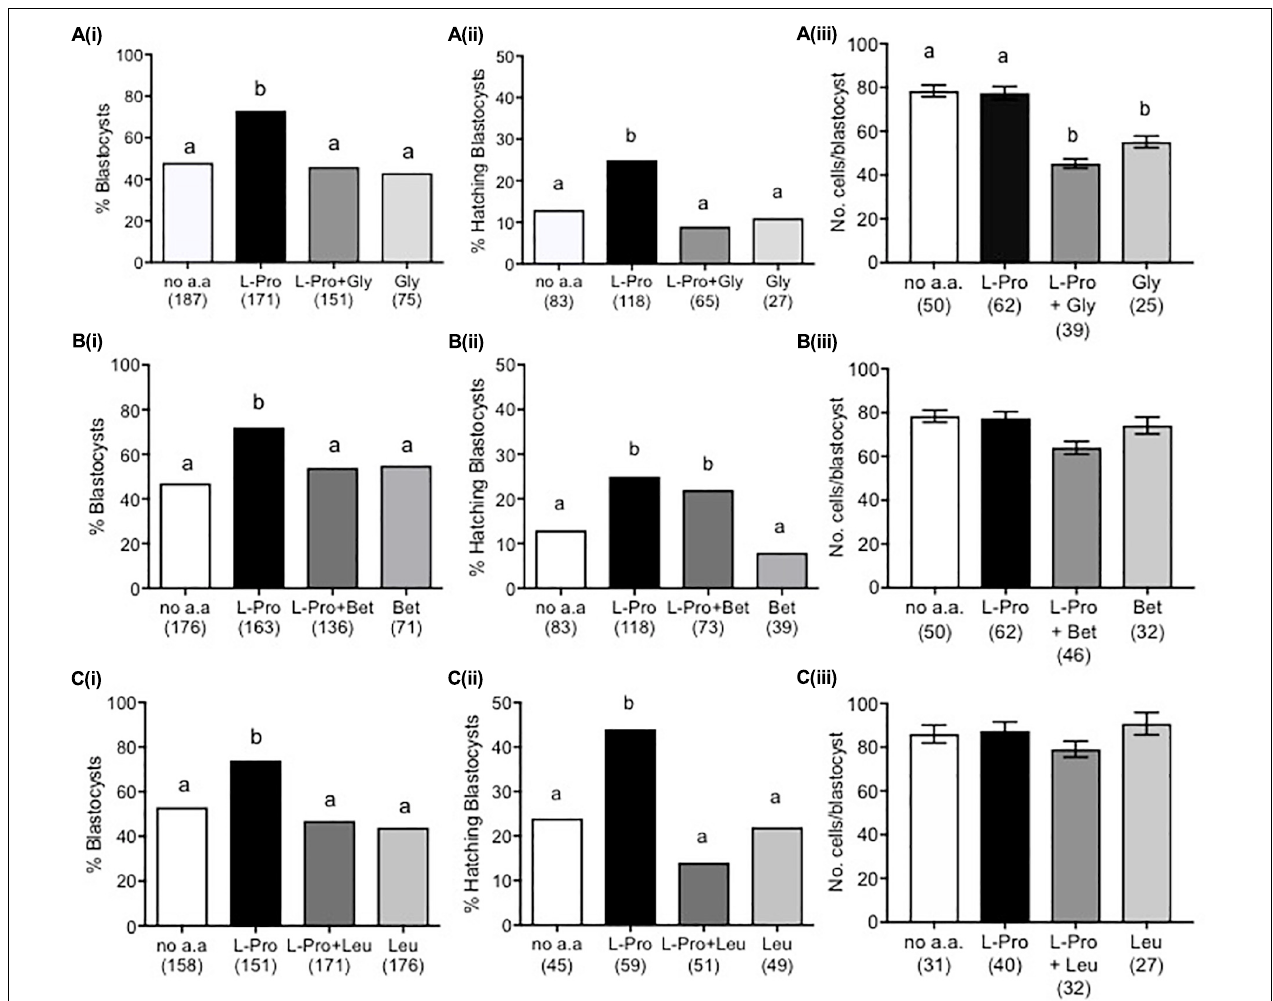
FIGURE 6 | Effect of molar excess of Gly, Betaine and L-Leu on the L-Pro-mediated improvement in blastocyst development of mouse embryos cultured in isosmotic (270 mOsm/kg) medium at LD. Zygotes (20–22 h post-hCG) were cultured for 5 days in no amino acids (no a.a.), 400 µ M L-Pro alone or 400 µ M L-Pro in the presence of (A) 5 mM Gly, (B) 5 mM Betaine or (C) 5 mM L-Leu. (i) Percentage of blastocyst development. (ii) Percentage of blastocysts hatching. (iii) Number of cells in blastocysts. Values in (iii) are mean ± SEM. The number of embryos analyzed from at least three separate experiments is given in parentheses. Bars with different letters are significantly different ( P < 0.05) using Fisher’s exact test, with Bonferroni correction for multiple comparisons, and one-way ANOVA with Tukey’s post hoc test for mean values.